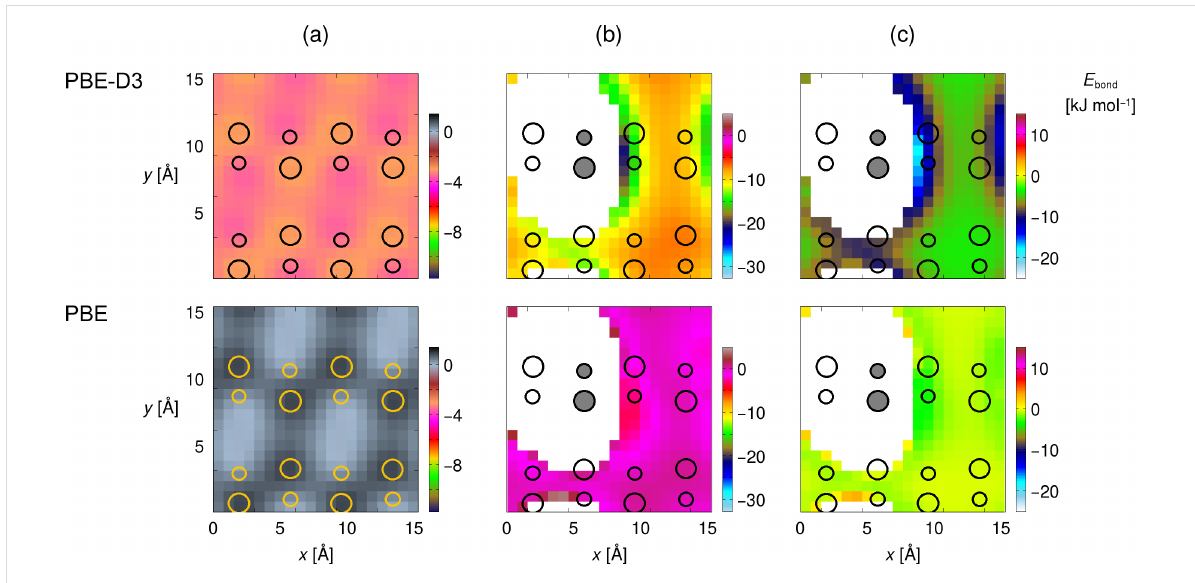
Figure 5: Frozen PES scans of 1 along path indicated in Figure 4 ( C 2 axis parallel to z , C ≡ C parallel to y , Δ z (Si up –C triple ) = 5 Å) on (a) the clean and (b) the precovered surface, and (c) the difference between (a) and (b). Circles denote surface atoms, grey shading denotes the occupied site. White region: no values given due to highly repulsive interactions or overlapping molecules.